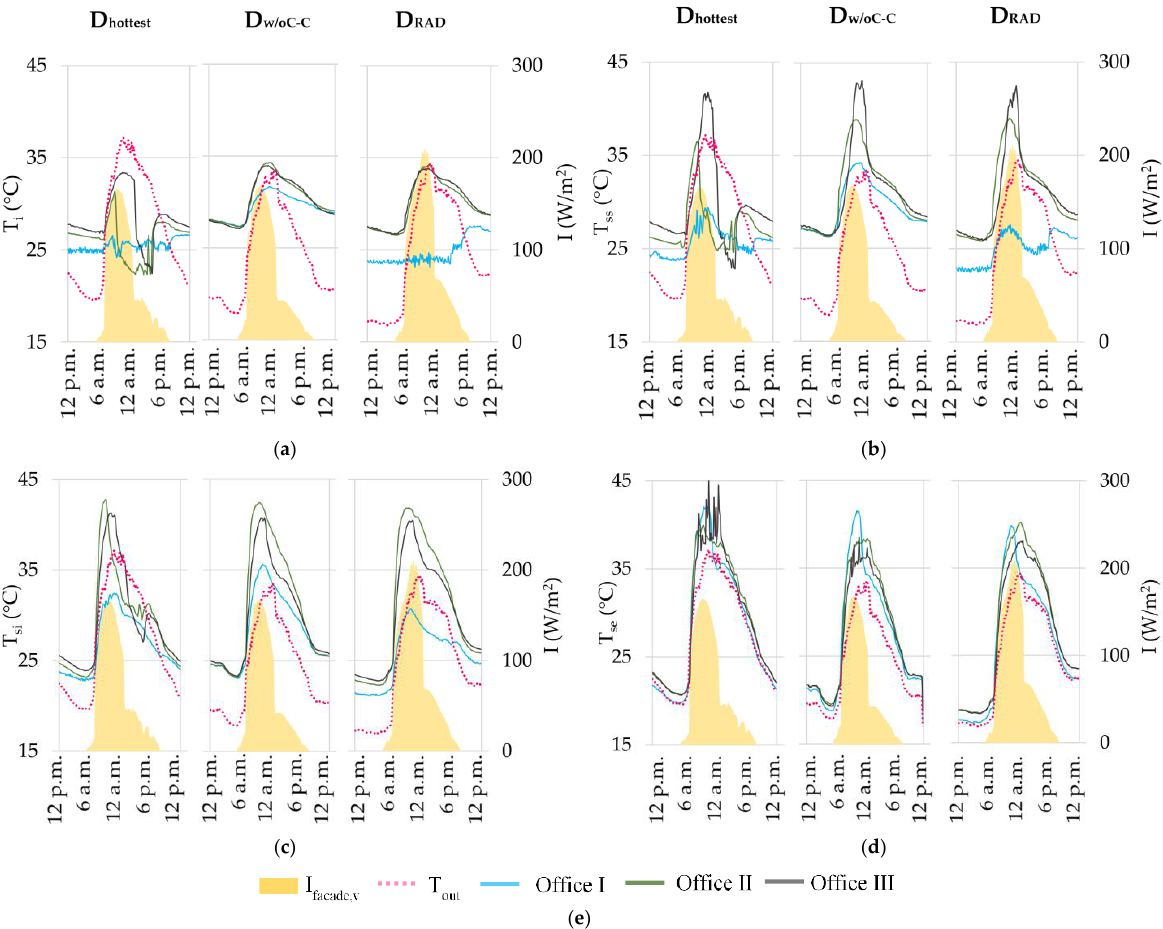
Figure 11. Experimental results for the cooling period representative days: ( a ) indoor air temperature, 𝑇 𝑖 ; ( b ) shading slats temperature, 𝑇 𝑠𝑠 ; ( c ) internal surface temperature of the glazing systems, 𝑇 𝑠𝑖 ; ( d ) external surface temperature of the glazing systems, 𝑇 𝑠e ; ( e ) legend.